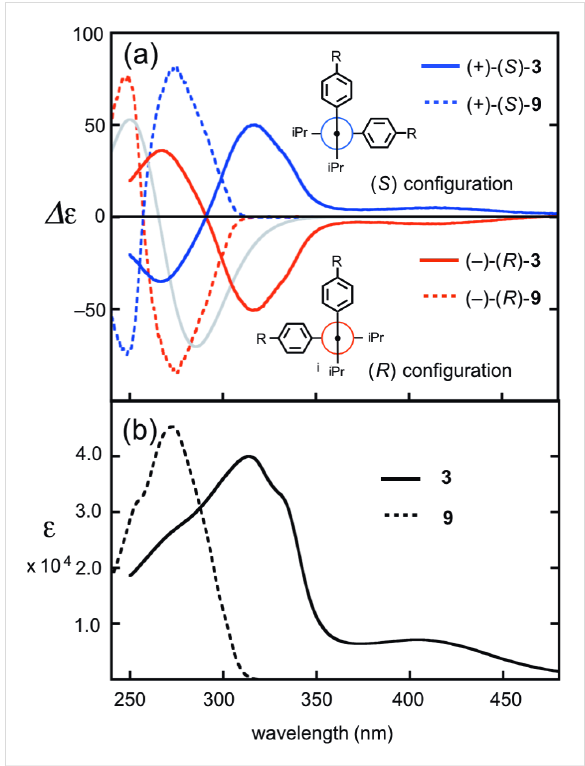
Figure 2: (a) ECD spectra of ( R )-( − )- 3 (3.5 × 10 − 5 M), ( S )-(+)- 3 (3.8 × 10 − 5 M), ( R )-( − )- 9 (3.0 × 10 − 5 M), and ( S )-(+)- 9 (2.9 × 10 − 5 M) in CH 2 Cl 2 together with the simulated ECD spectra of 3 and 9 in ( R )-con- figuration. (b) UV spectra of 3 (3.5 × 10 − 5 M) and 9 (3.8 × 10 − 5 M) in CH 2 Cl 2